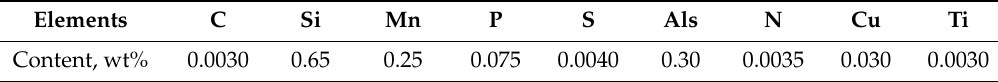
Table 1. The main chemical composition of non-oriented electrical steel.